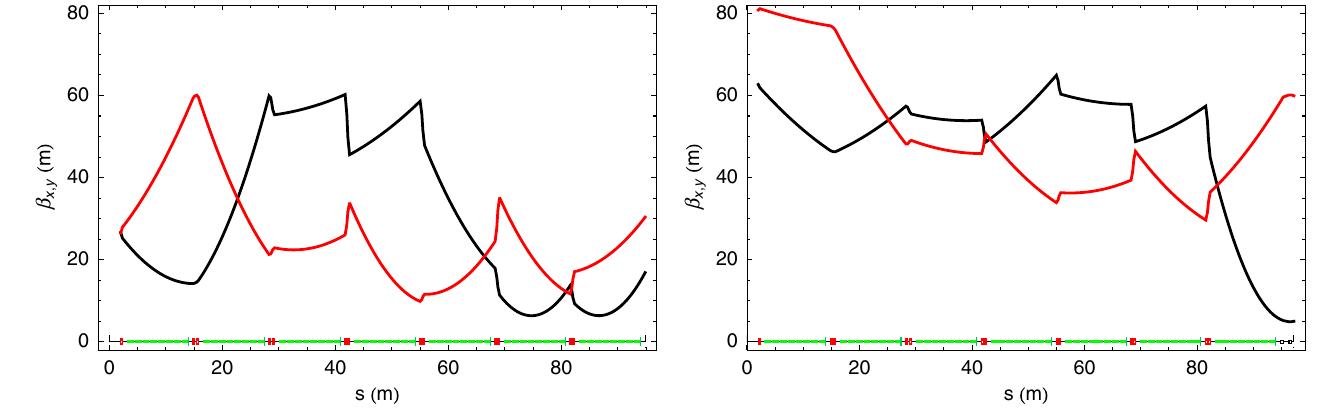
FIG. 8. Simultaneous optics functions for first (left) and second (right) pass of main linac.